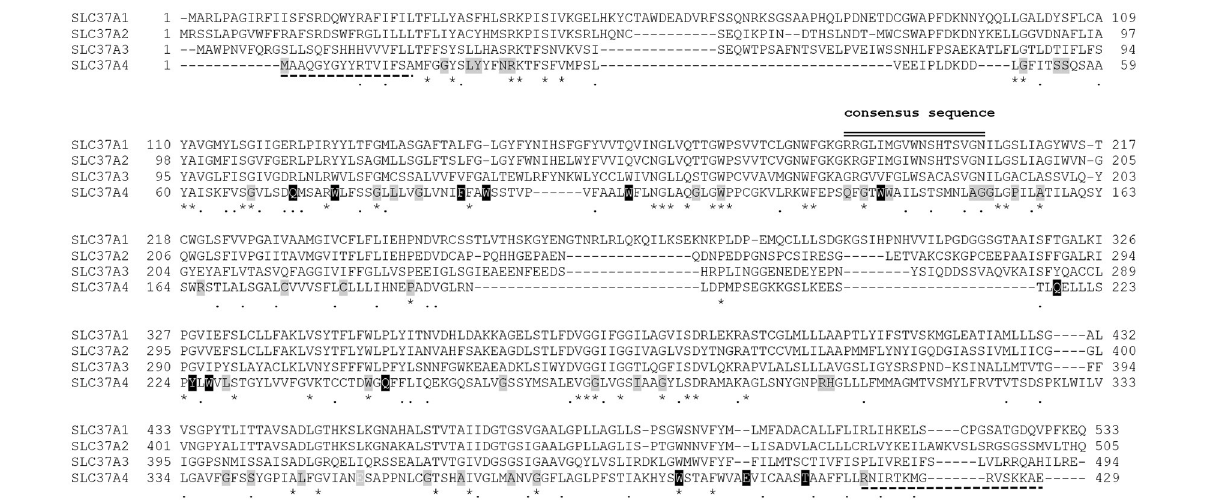
FIGURE 1 | Alignment of the amino acid sequences of human SLC37A1, SLC37A2, SLC37A3, and SLC37A4 showing the location of nonsense and missense mutations identified in GSD-Ib patients. The aligned amino acid sequences are GENBANK accession numbers NP_061837.3 (SLC37A1), NP_938018.1 (SLC37A2), AAH46567.1 (SLC37A3), and CAG33014.1 (SLC37A4). Sequence conservation is indicated by an asterisk for identical residues, a dot for conserved substitutions, and a gap for non-conserved residues. The organo-phosphate/Pi antiporter family consensus sequence, ProSite PDOC00726, shared by the SLC37 family members is indicated by black double lines. Dashed black lines show lacking residues at the N- or C- terminal end in mutants MIV and R415X, respectively. Nonsense and missense mutations are highlighted in black or gray, respectively. Alignment has been performed by